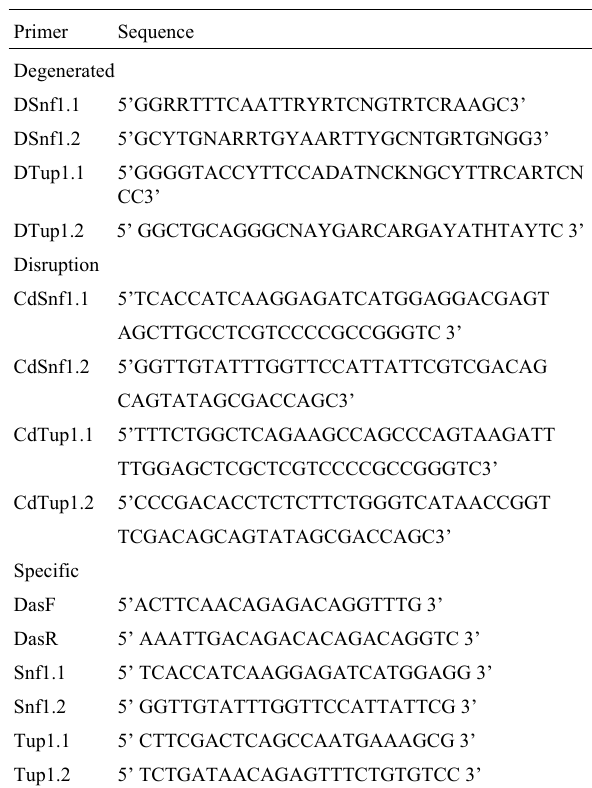
Table 1 - Primers used in this